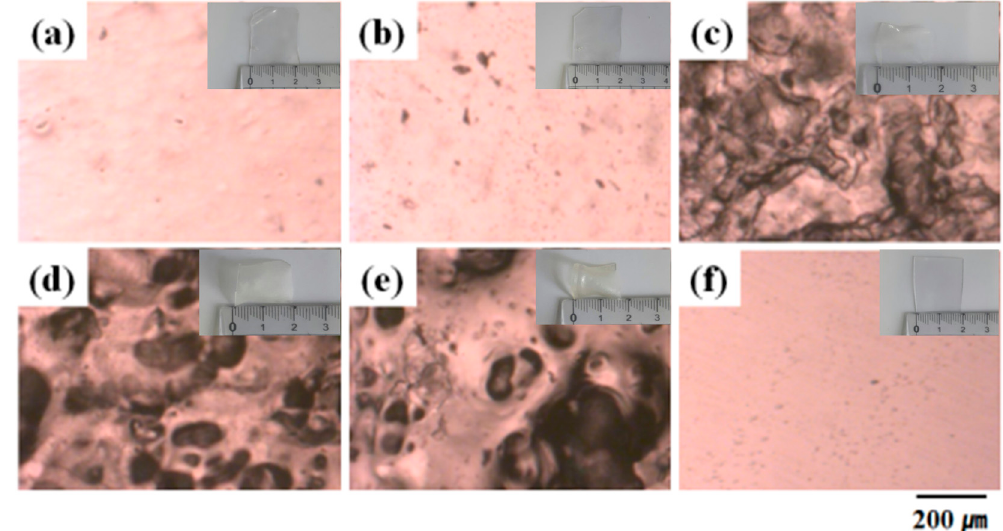
Figure 6. Optical microscopy images and macrographs of the ( a ) pure PVAc film; ( b – e ) PVAc films heterogeneously saponified at 50 °C; and ( f ) general PVA film. The saponification times and DS values were ( b ) 24 h and 0%; ( c ) 48 h and 39.4%; ( d ) 72 h and 91.6%; and ( e ) 96 h and 97.6%.